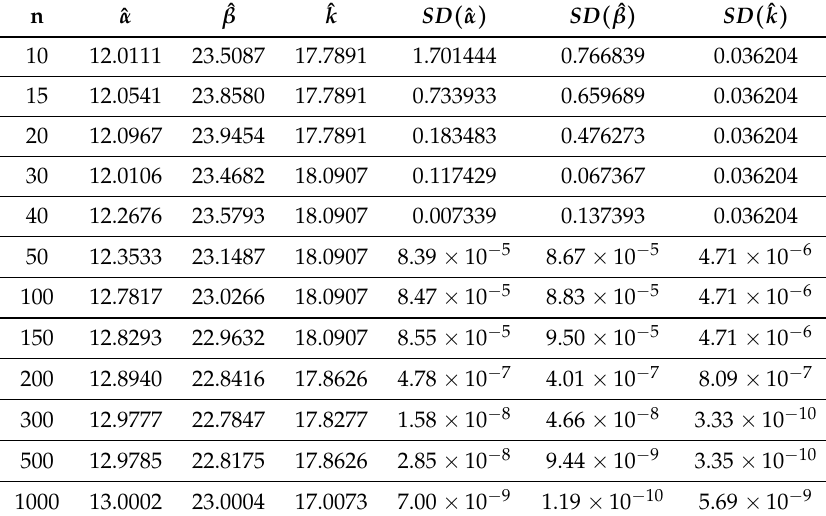
Table 11. Results of simulation with samples of censored data using the conjugate gradient method with m = 10,000, α = 13, β = 23, k = 18, θ = 0.15. n